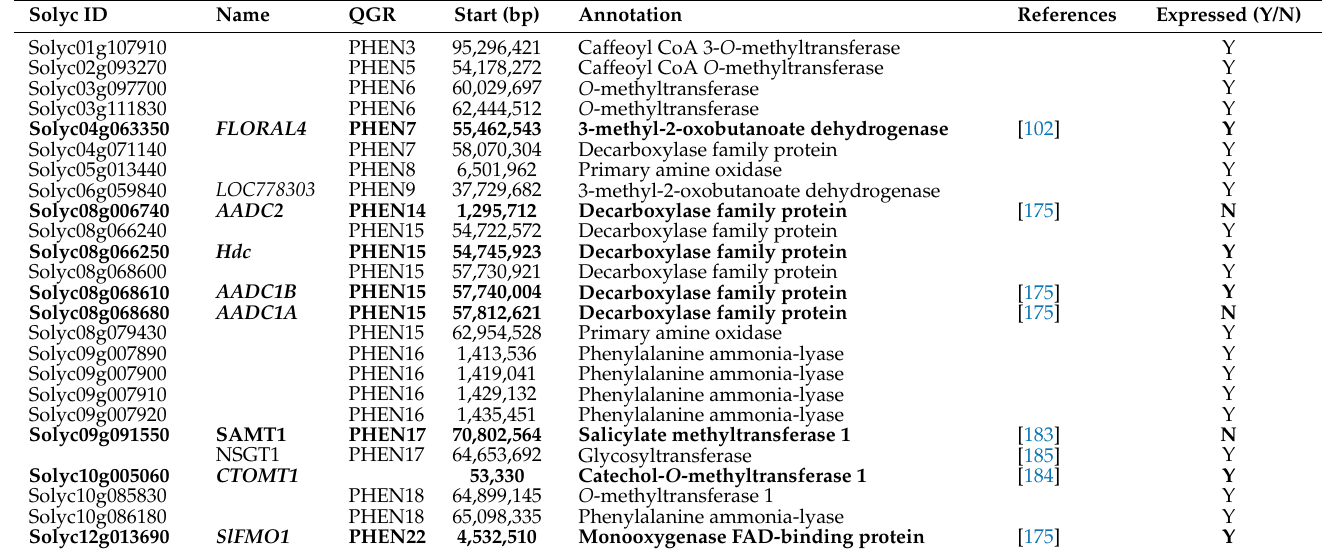
Table 6. List of the genes identified as potentially responsible for the phenylalanine-derived VOCs QTL reported in literature. Genes that have been functionally characterized are highlighted in bold in the table. The last column reports whether the gene has been reported to be expressed in fruit (Y/N—[103]); for a complete overview of the gene expression see Table